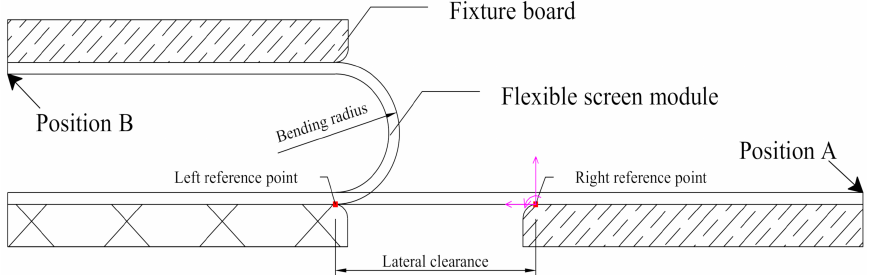
Figure 1. Geometric structure model of U-shaped bending mode. The left reference point was fixed, and the bending was performed by moving the fixture board from position A to position B within the bending time t seconds. The lateral gap was π R since the bending angle was π and the bending radius was R